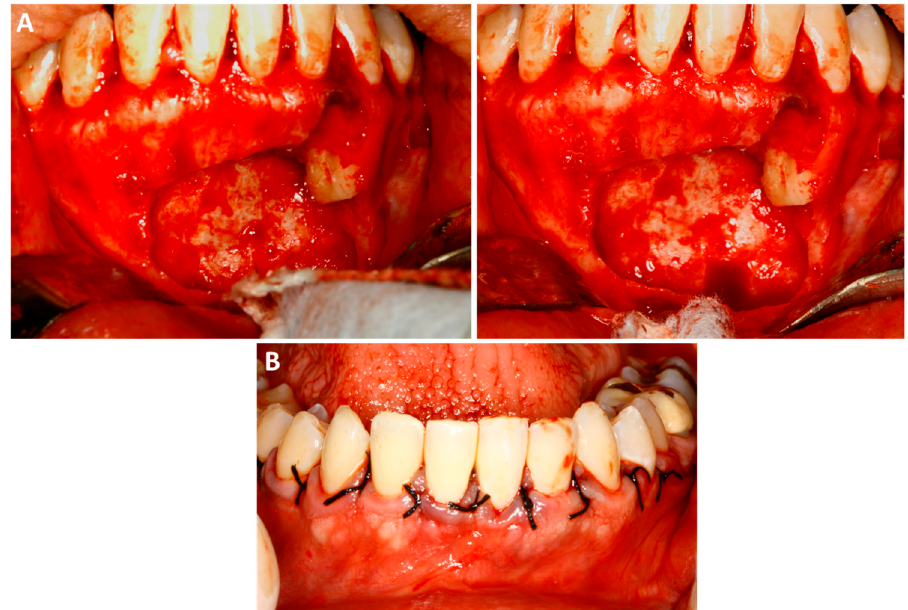
Figure 3. Trans-operative images of the surgical procedure. ( A )—First surgery—the surgical access and the ostectomy were performed via vestibular cortex. ( B )—Surgical flap was positioned, and sutures were